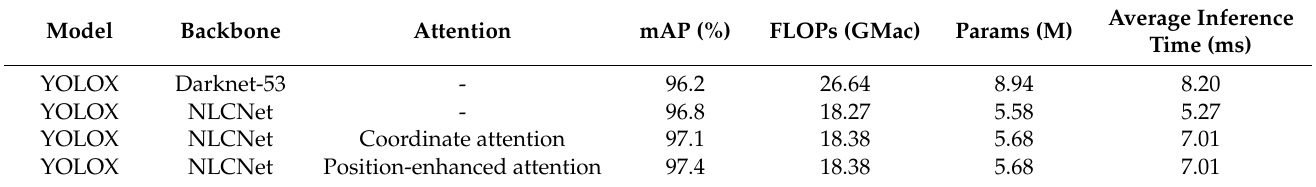
Table 3. Results of ablation experiments. (mAP, FLOPs, Params and average inference time represent detection accuracy, computational complexity, parameter amount and average inference time,